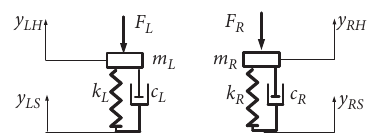
Figure 7: Left and right collector strip of the